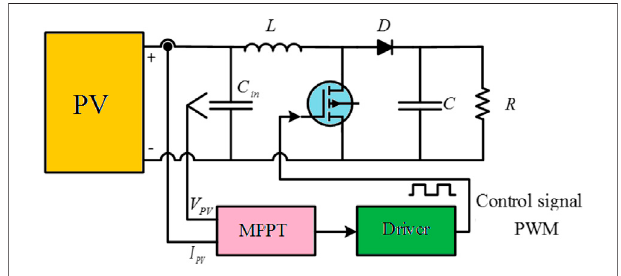
FIGURE 2 | Schematic of MPPT solution